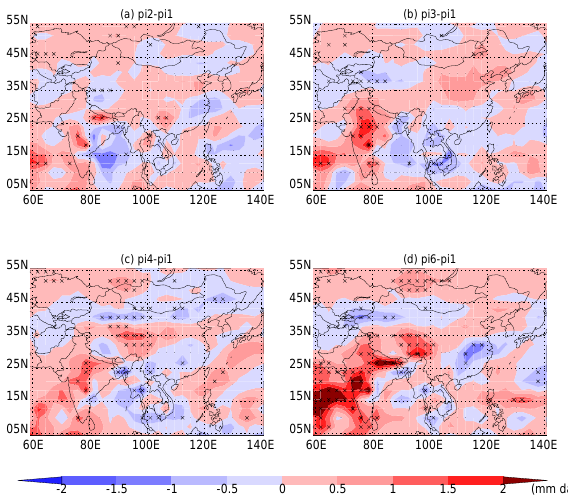
Fig. A2 Same as Fig. A1 but for